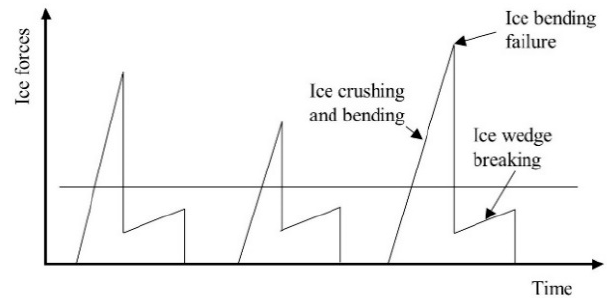
Figure 1. Idealized time histories of ice